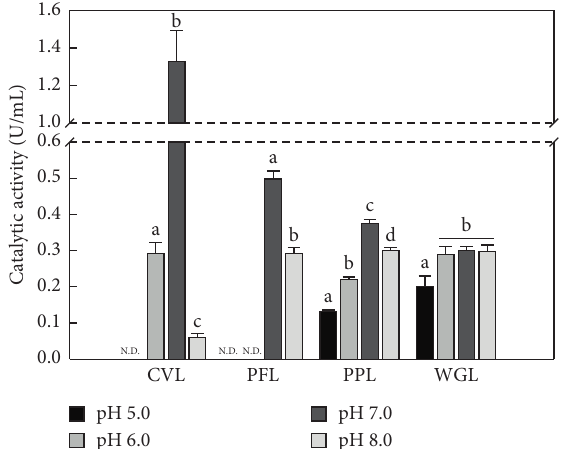
Figure 2: Effects of operating pH on the catalytic activity of lipases against p -nitrophenyl palmitate as a substrate. The operating pH was in the range of 5.0–8.0. Error bars indicate the standard error of the mean. Superscripts (a–d) above the bars denote significant differences in catalytic activity ( p < 0 . 05, Duncan’s multiple range test on ANOVA). CVL, Chromobacterium viscosum lipase (0.01mg/mL); PFL, Pseudomonas fluorescens lipase (0.001mg/mL); PPL, porcine ( Sus scrofa ) pancreatic lipase (10mg/mL); WGL, wheat germ ( Triticum aestivum ) lipase (1mg/mL); N.D, not